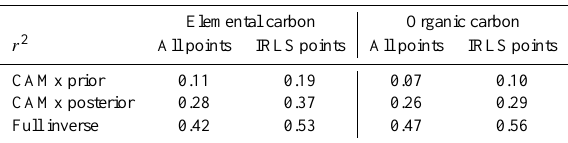
Figure 8. Contributions of different types of sources to the average concentration of EC and OC at the St. Louis–Midwest supersite using the LADCO inventory (prior) and the least squares inverse model (posterior). Table 3. Pearson’s correlation coefficient squared for simulated time series of EC and OC for the complete time series as well as for the subset of points included in the inversion after the Iteratively Reweighted Least Squares (IRLS) procedure. The full inverse time series is the sum of the CAMx posterior and the impacts due to the gridded back